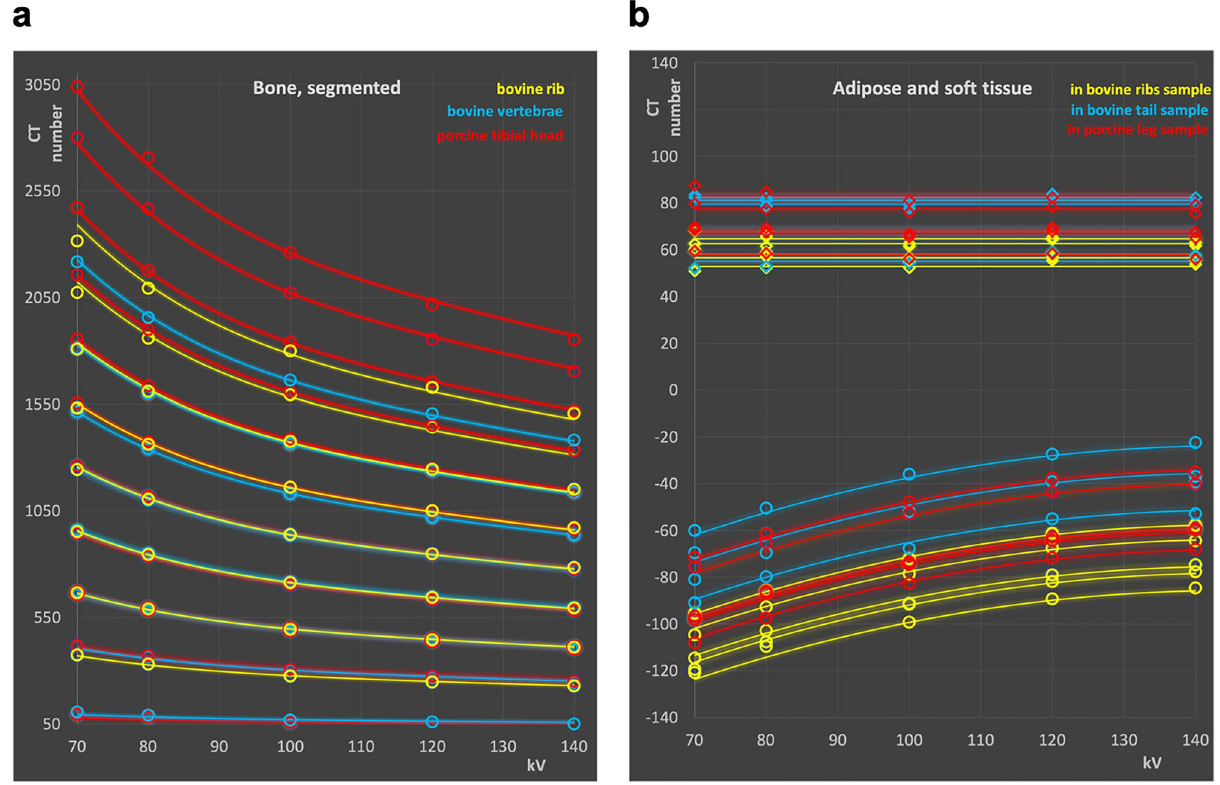
Figure 2. CT numbers from segmented bone samples ( a ), and soft tissues ( b ). Diamonds represent soft tissue (mainly muscular tissue), and circles adipose tissue. ( a ) and ( b ): Symbols: measured points, lines: model equation.